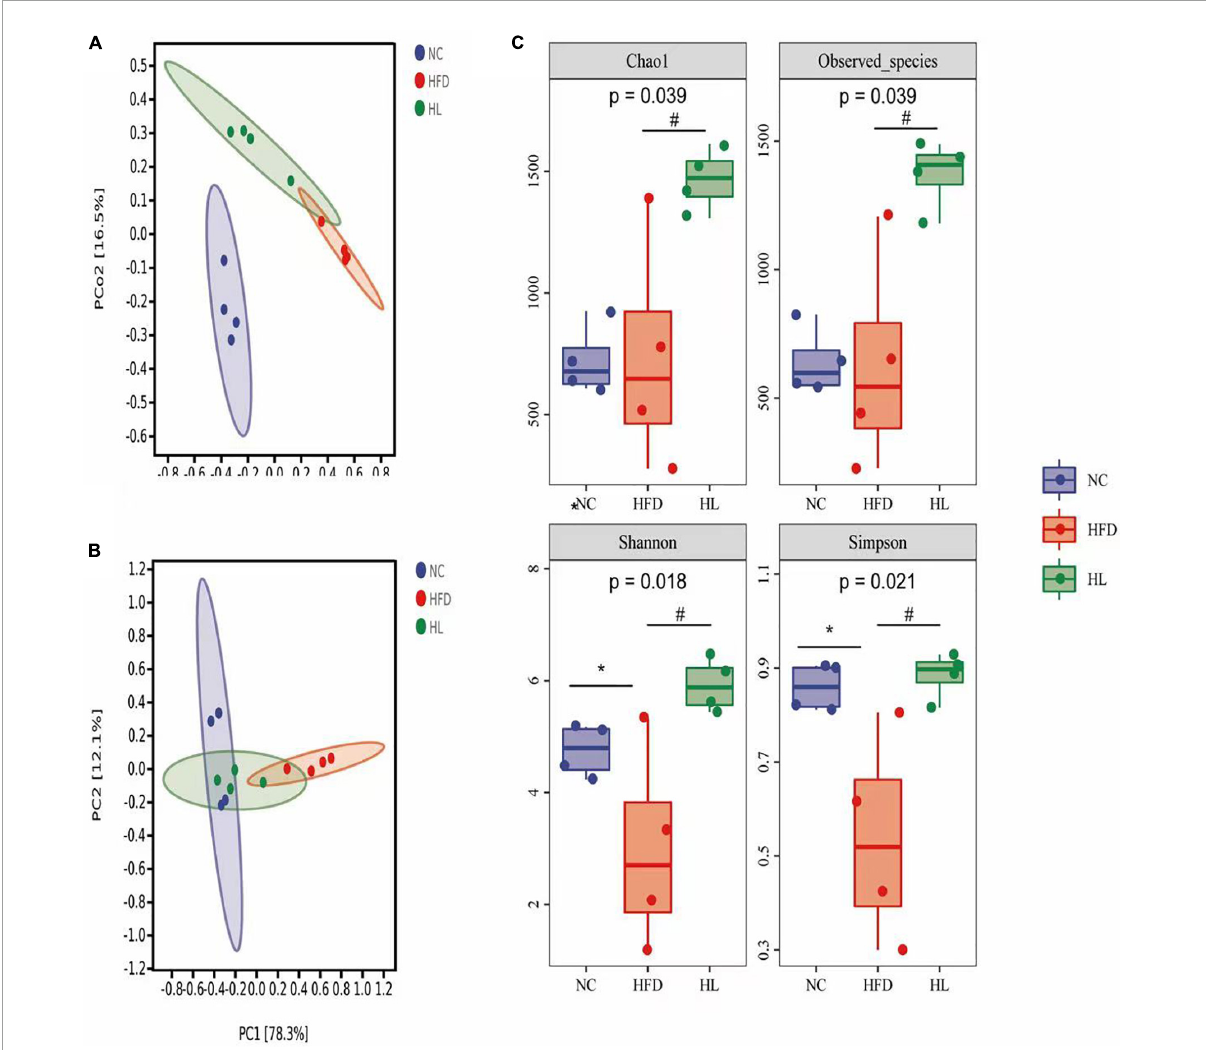
FIGURE3 Liraglutide altered the overall structure of gut microbiota in HFD-fed mice. (A) Principal coordinates analysis (PCoA). (B) Principal components analysis (PCA). (C) Alpha-diversity metrics (Chao1, Observed_species, Shannon, and Simpson). Data are presented as the mean ± SEM. * p < 0.05 vs. NC group; # p < 0.05 vs. HFD